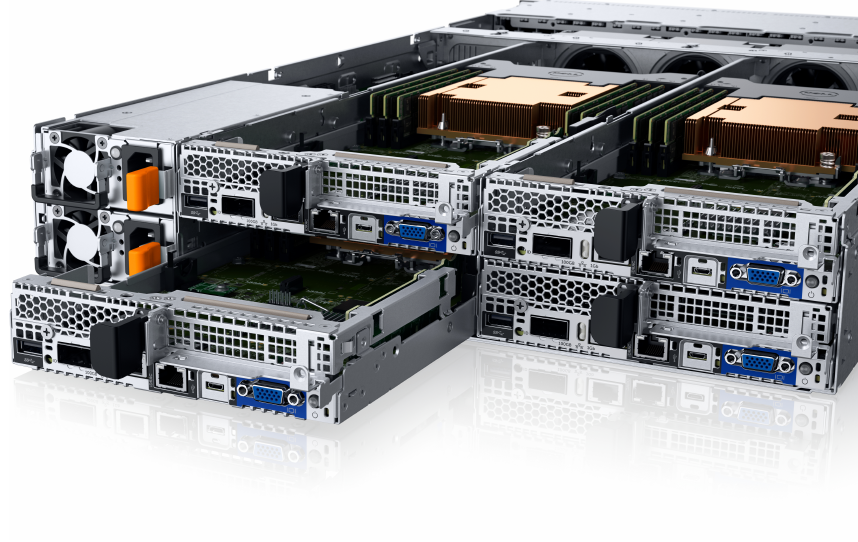
Figure 3: Example of a Dell C6320P server system. The model used in the JURECA Booster slightly deviates from the shown version due to the utilized processor type. Copyright: Dell